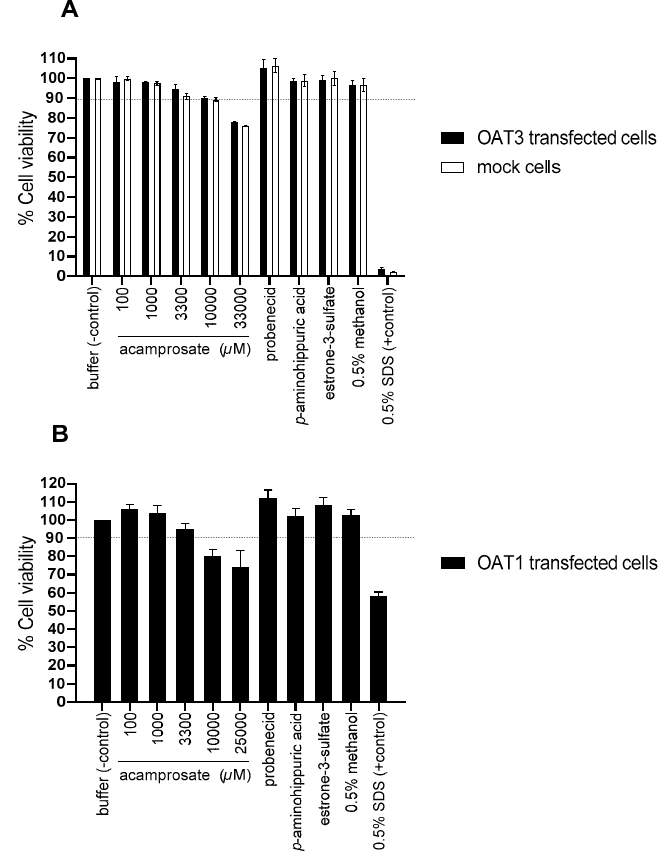
Figure 8. Evaluating the effect of the applied compounds on HEK 293 cell viability. The cell viability assessed using CellTiter Glow and ATP was measured the cells were treated for 3 h with either uptake bu ff er (control) or 0.1, 1000, 3300, 10,000, 25,000, or 33,000 µ M acamprosate, 1 mM probenecid, 1000 µ M p -aminohippuric acid, 200 µ M estrone-3-sulfate, 0.5% methanol, and 0.5% SDS. The measurement was done in OAT3 ( A ) or OAT1 ( B ) transfected cells (black bars) or mock cells ( A , white bars). Each bar depicts the mean ± SEM of replicates in three ( A ) or four ( B ) independent cell passages obtained at Lab.